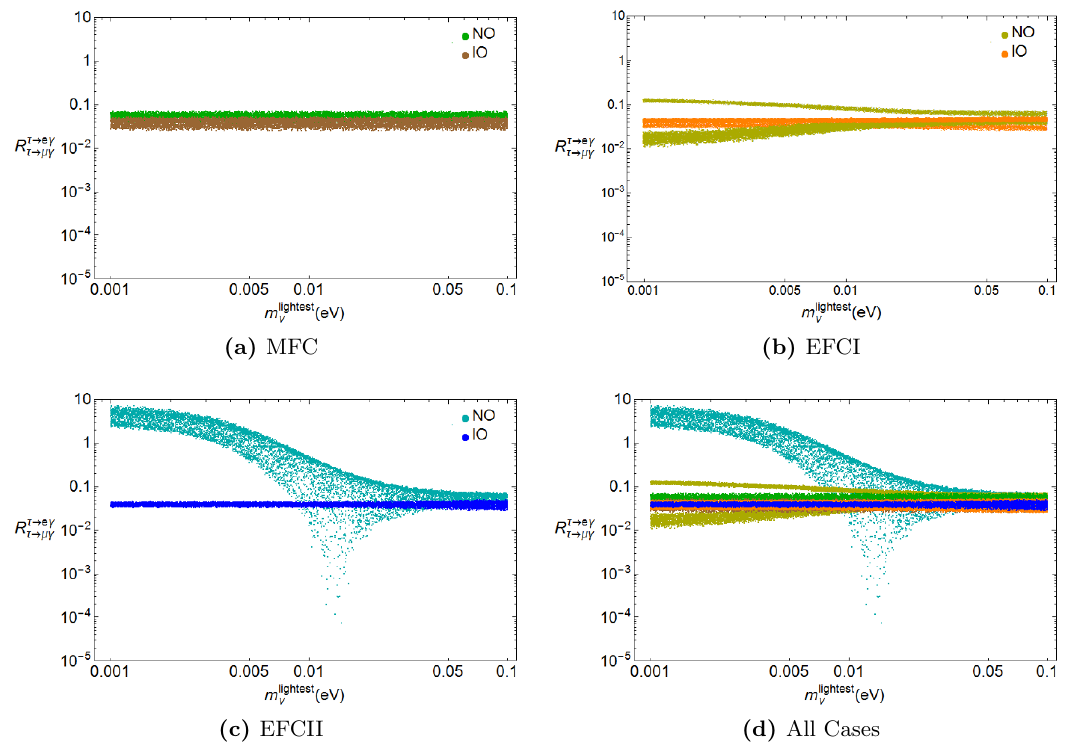
Figure 4. R (cid:28) ! e(cid:13) for the MFC, EFCI and EFCII from upper left to lower left. Lower right reports (cid:28) ! (cid:22)(cid:13) the previous plots altogether. Colour codes can be read directly on each